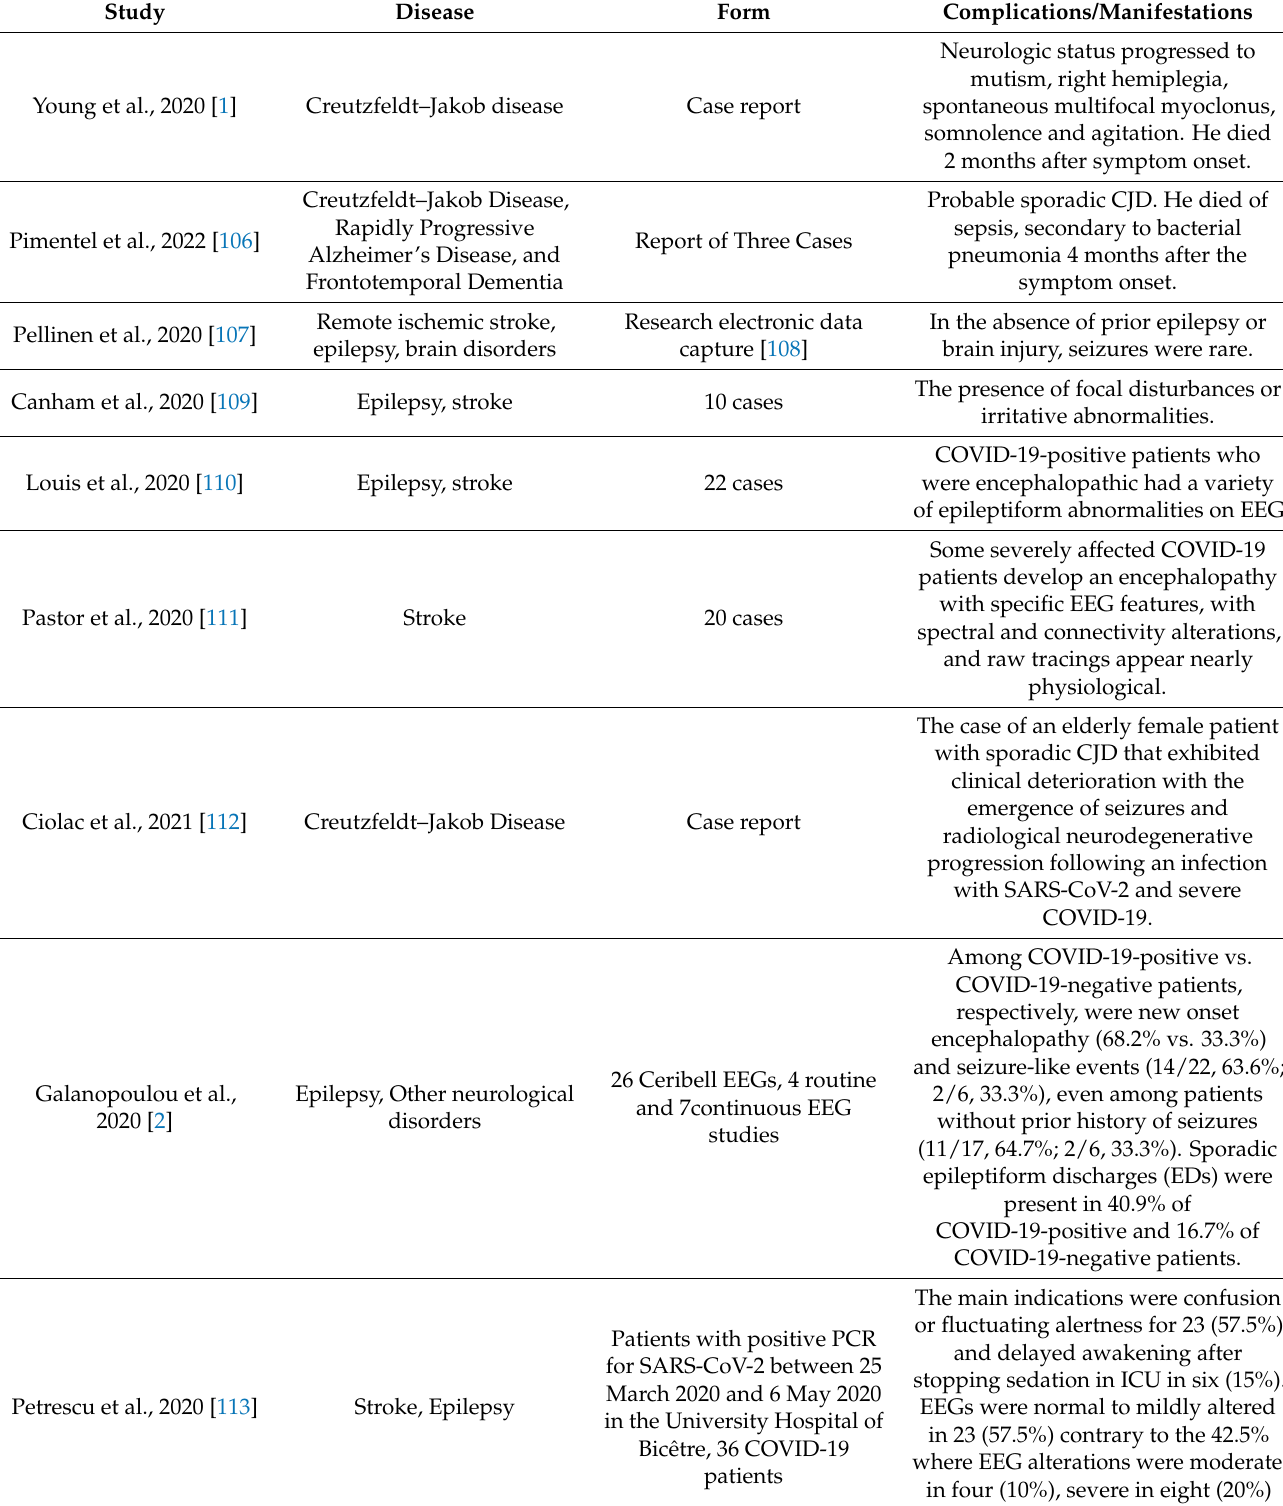
Table 2. Articles included in the review associated with brain